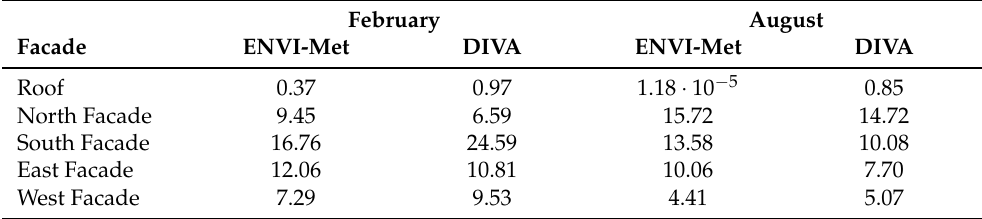
Table 5. Normalized root mean squared error of the predicted level of irradiance (%) for the homoge- neous